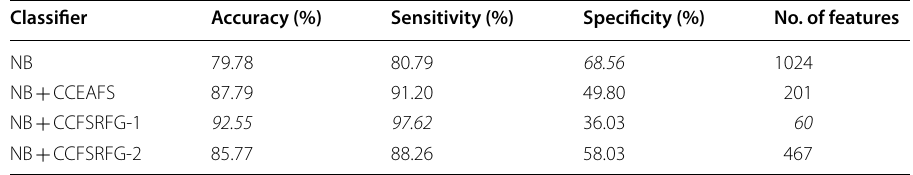
Italic signifies the improvements of the proposed approach over existing techniques Table 13 Summary of results for the Colon Cancer Dataset